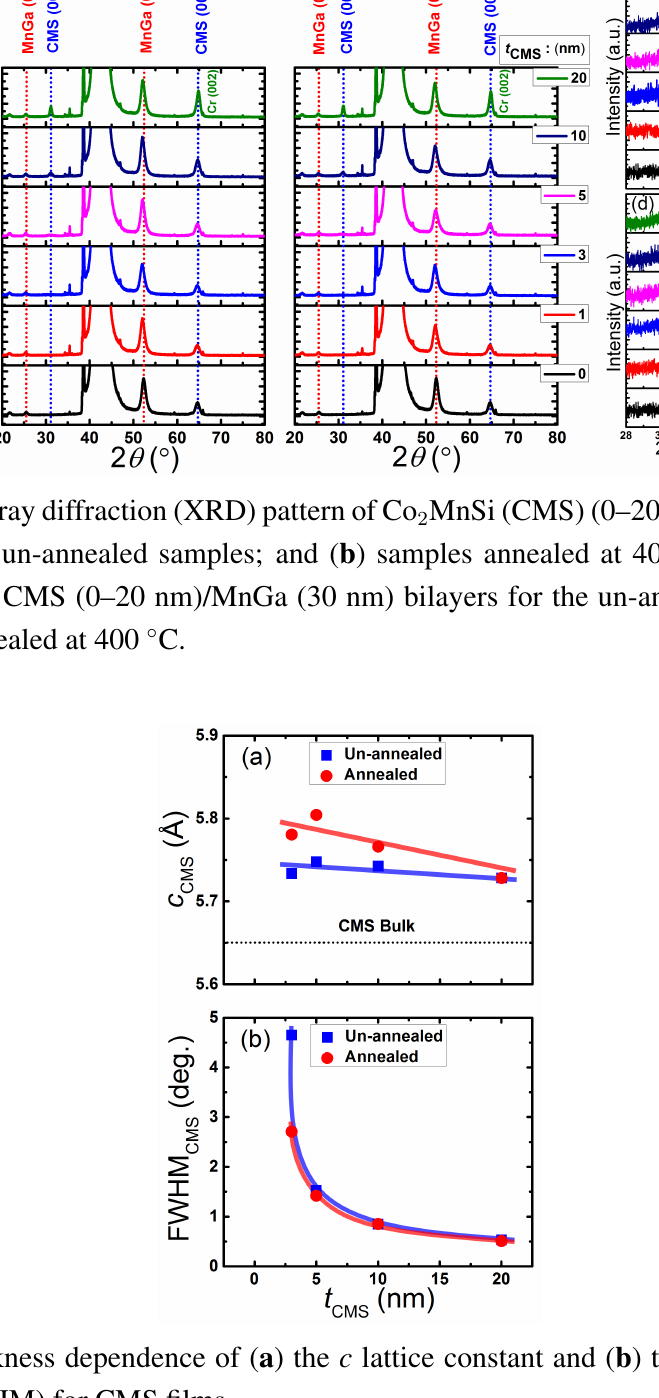
Figure 2. Thickness dependence of ( a ) the c lattice constant and ( b ) the full width at half maximum (FWHM) for CMS